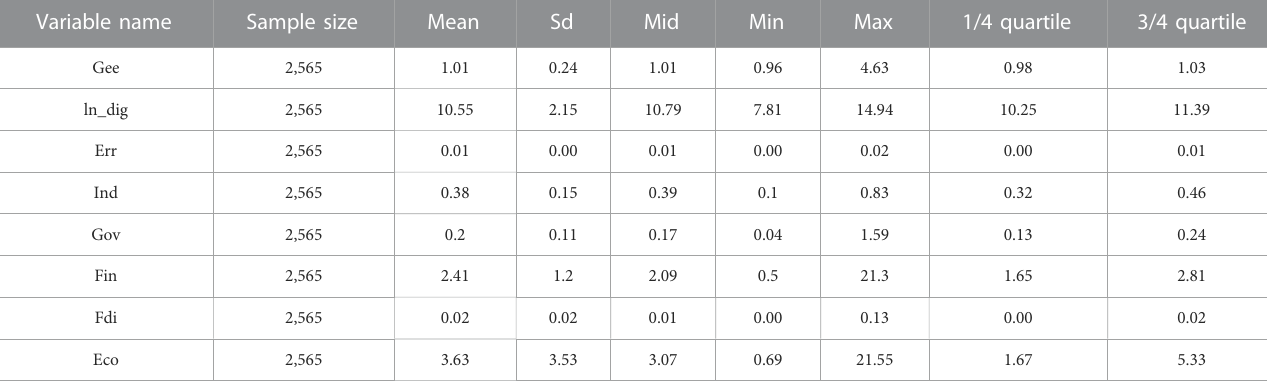
TABLE 2 Variables ’ descriptive